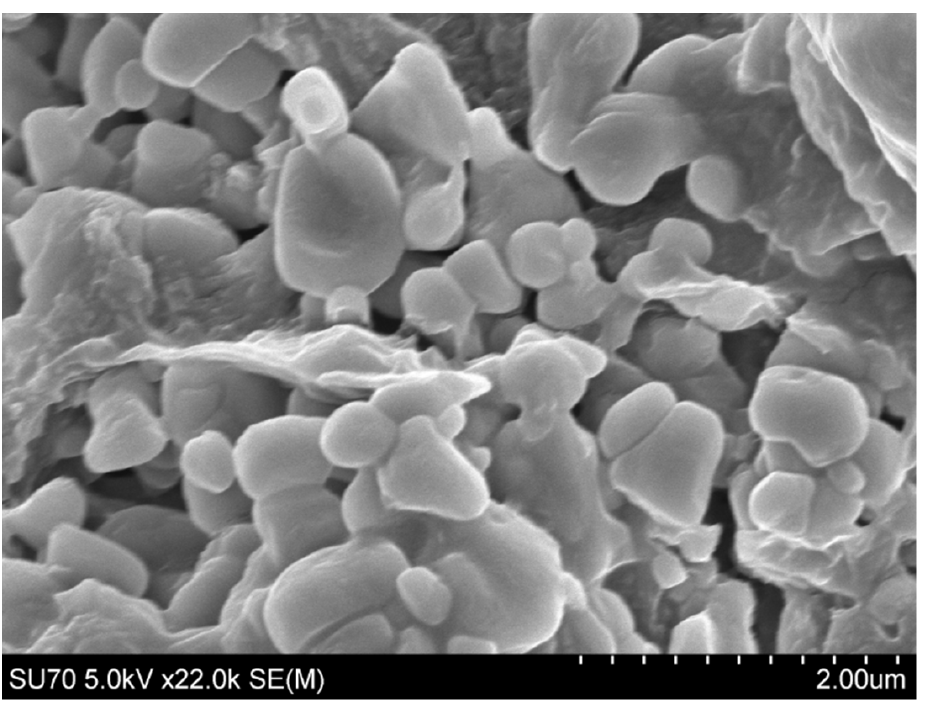
Figure 4. SEM image of deposited MMSC ECM electrosprayed nanoparticles on aluminum foil before purification.